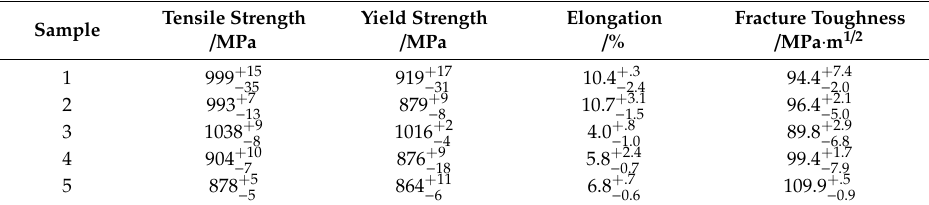
Table 4. Tensile properties of TC4F alloy after di ff erent heat